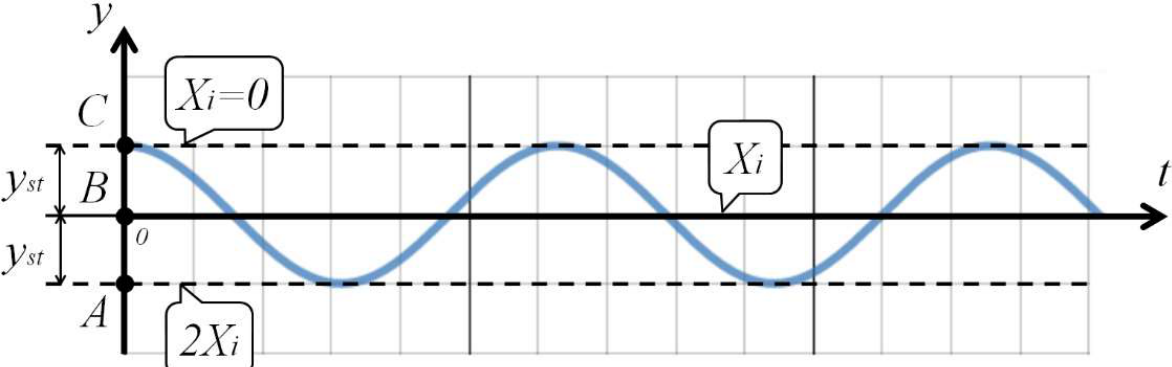
Figure 7. Graph of the oscillation process of the end of the pipeline.